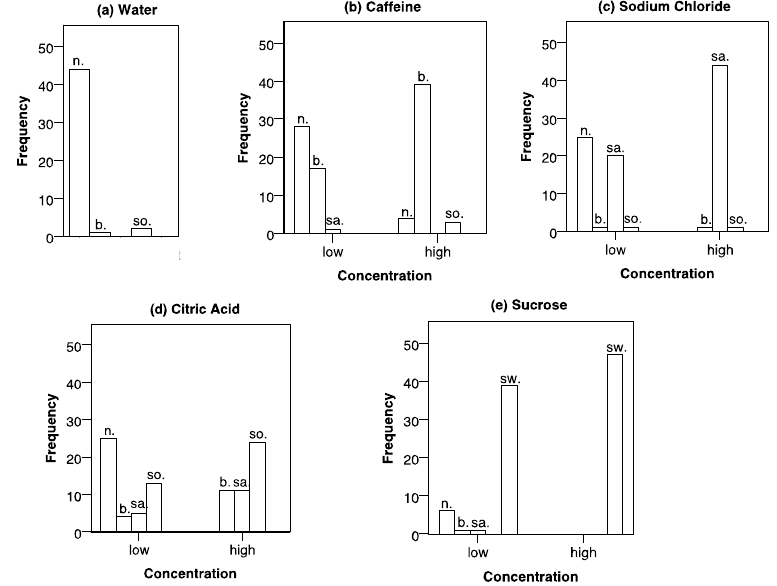
Figure 2. Taste identification frequency (y axis) for each stimulus by low and high concentration (x axis). Each plot represents a specific taste stimulus: ( a ) water; ( b ) caffeine; ( c ) sodium chloride; ( d ) citric acid; ( e ) sucrose. Bars are coded by reported taste quality: neutral (n), bitter (b), salty (sa), sour (so), sweet (sw).